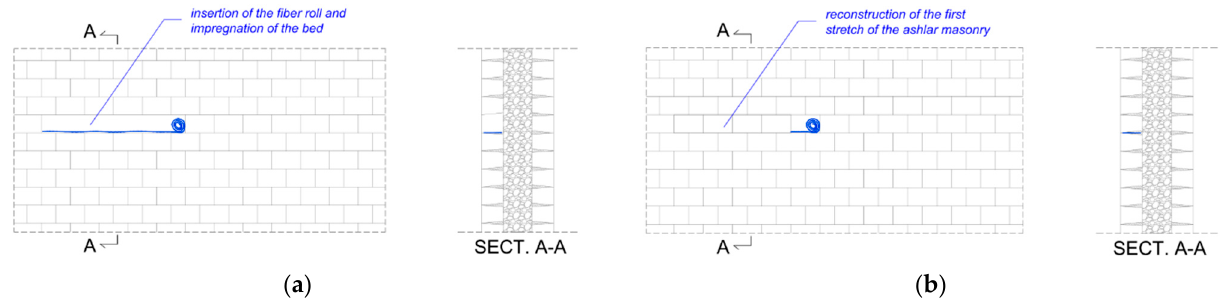
Figure 10. Relevant modifications of the proposed intervention for ashlar masonry: ( a ) unrolling and impregnation of the fiber roll; ( b ) reconstruction of the stretch of the ashlar course.